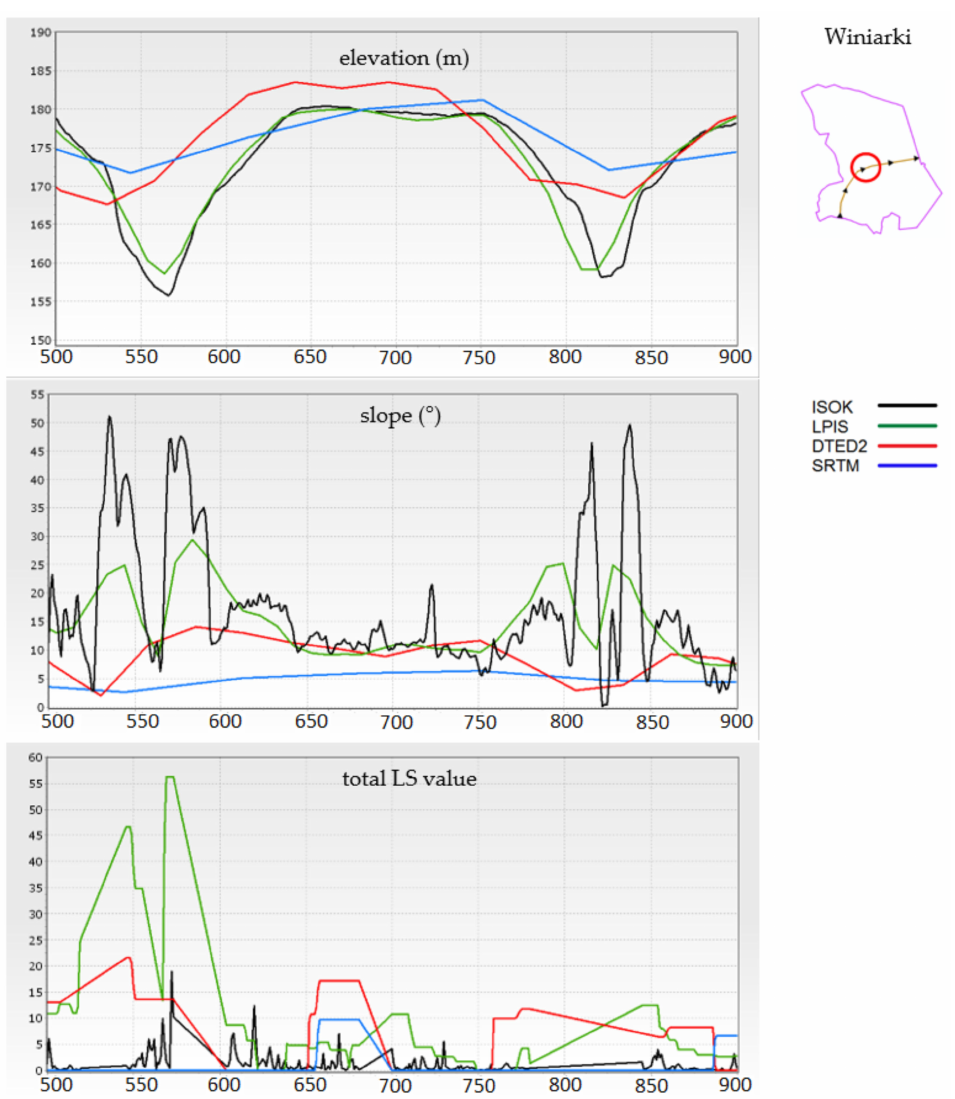
Figure 8. Visualisation of the elevation (m), slopes ( ◦ ) and the total LS factor values (Y-axis) calculated from all the DTM sources for a selected section of the profile (over a 400-m section) of the Winiarki research area (additional visualisations for Janowice and Bolcie research areas are presented in Appendix